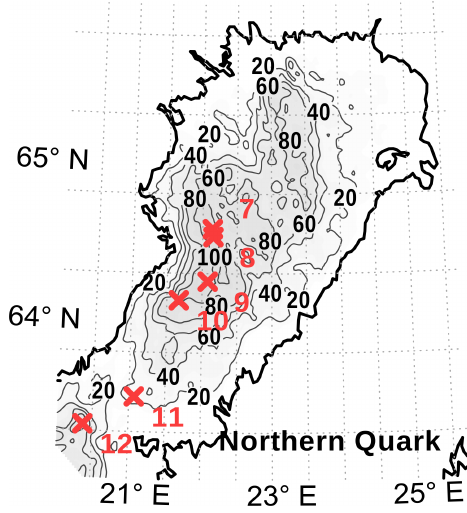
Figure 3. Locations of stations (red crosses) in the Bothnian Bay (stations 7 to 10), the Northern Quark (station 11), and the Both- nian Sea (station 12). Stations 7, 11, and 12 were CTD-only sta- tions. At stations 8, 9, and 10, sea ice and brine samples were taken. Near stations 9 and 10 also a CTD cast was performed. The map was created using the software package GrADS 2.1.1.b0 (http://cola.gmu.edu/grads/, last access: 19 June 2020), using pub- lished bathymetry data (Seifert et al.,